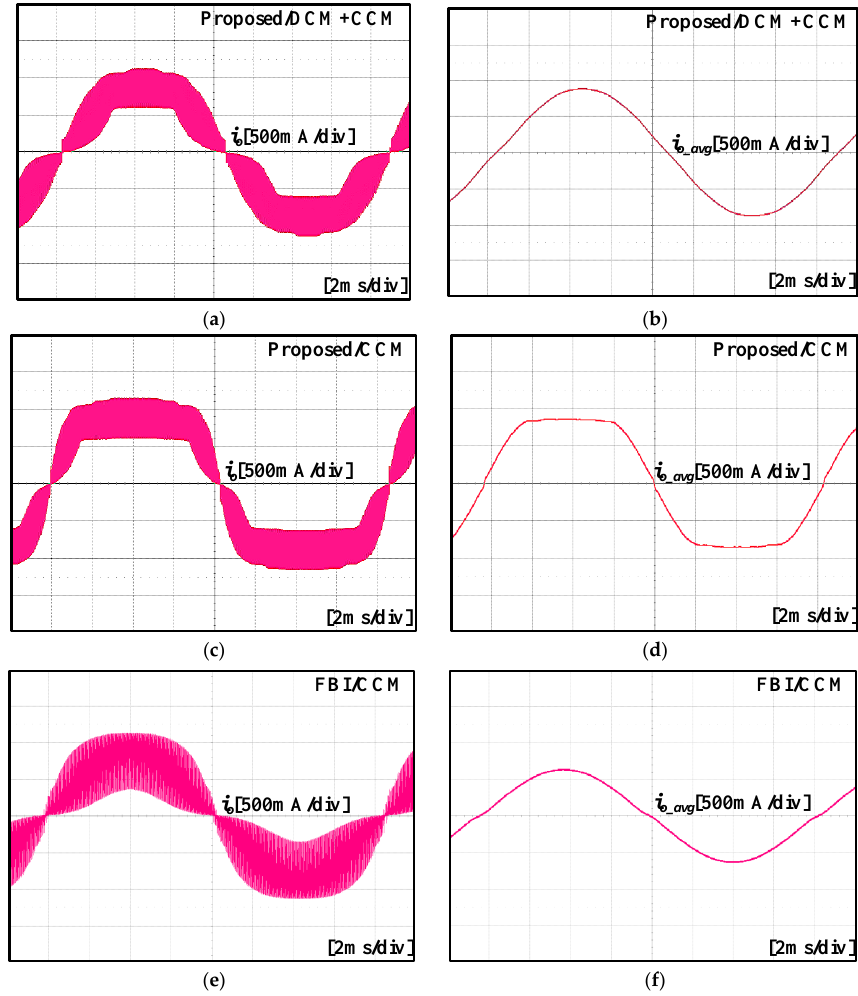
Figure 15. Waveforms of i o and i o_avg measured at at V in = 400 V DC , V grid = 220 V AC / 60 Hz, fs = 20 kHz, P o = 150 W, Q o = 0 VAR, and I o = 0.95 A: (a) i o (Proposed, DCM+CCM), (b) i o_avg (Proposed, DCM+CCM), P o = 150 W, Q o = 0 VAR, and I o = 0.95 A: (a) i o (Proposed, DCM + CCM), (b) i o_avg (Proposed, DCM +